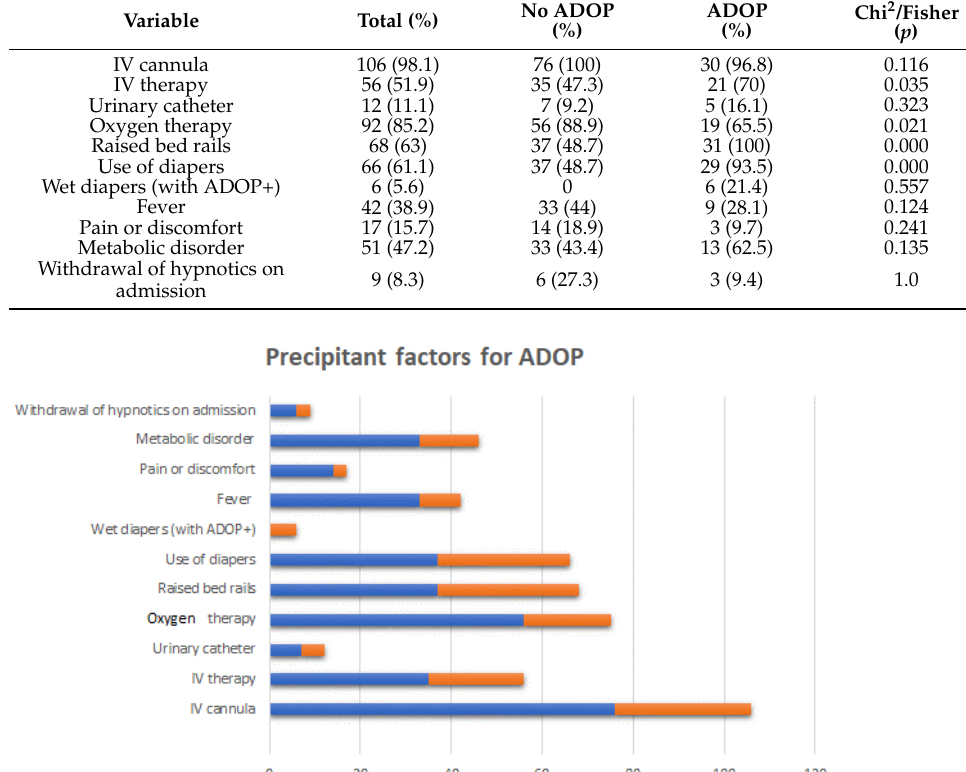
Table 3. Precipitant factors for ADOP.